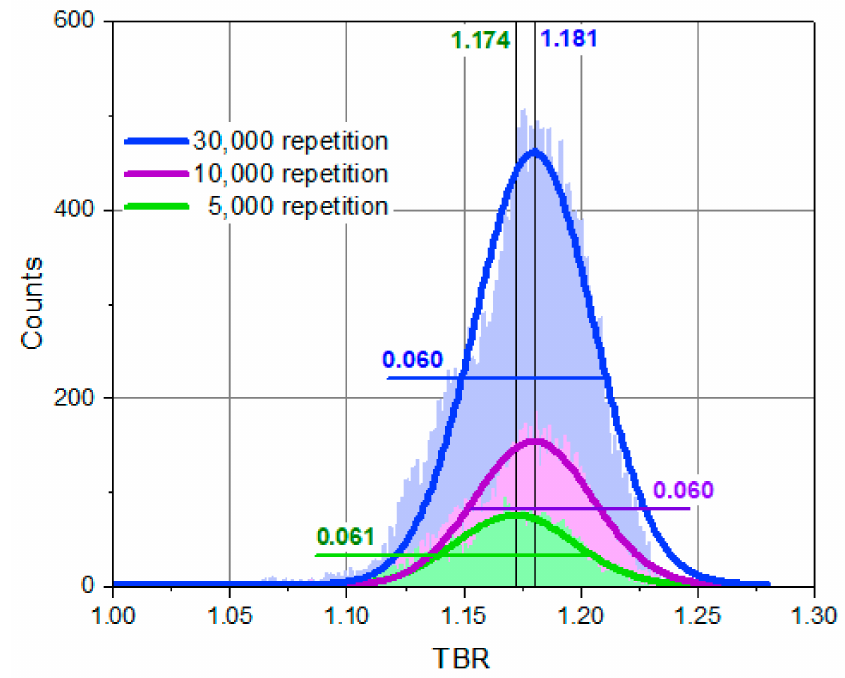
Figure 5. Distributions of the TBR for different TMC repetitions